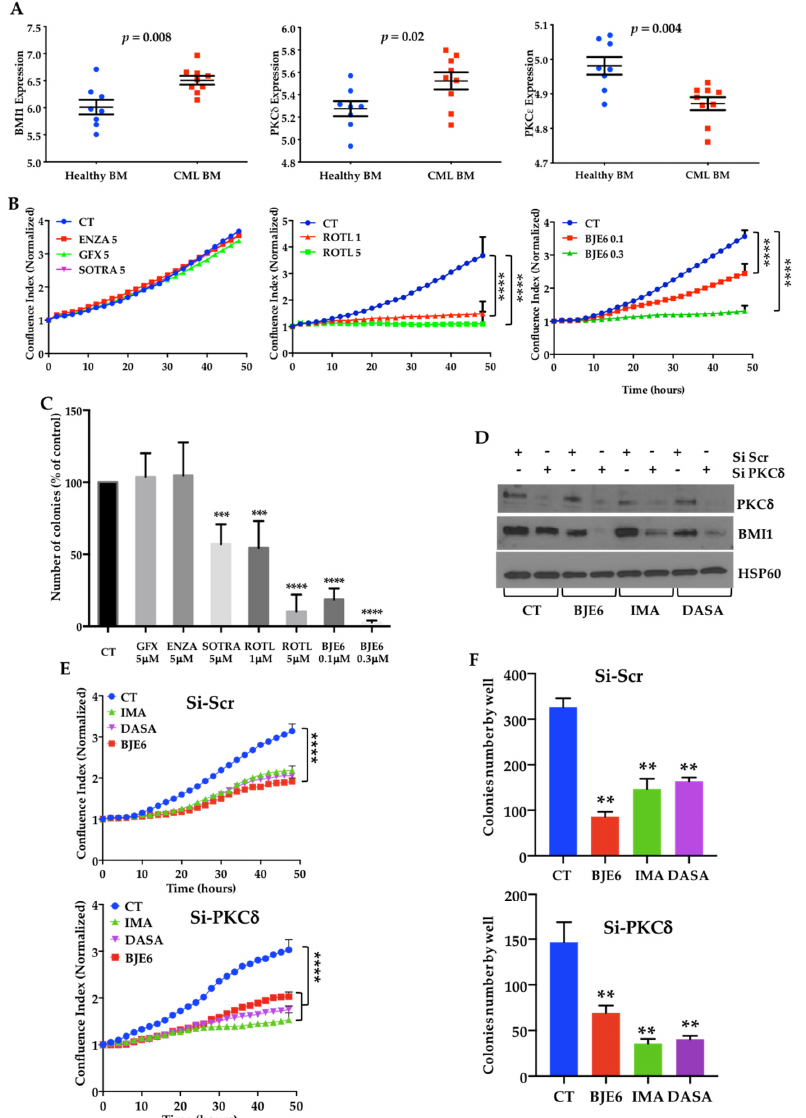
Figure 1. Targeting protein kinase C δ (PKC δ ) inhibited proliferation and clonogenicity of K562 cells. ( A ) BMI1, PKC δ , and PKC ε gene expression in bone marrow CD34 + cells from healthy donors and chronic myeloid leukemia (CML) patients (GSE5550). ( B ) Time-lapse proliferation analysis of K562 cells treated for 48 h with Dimethyl Sulfoxide (DMSO) (CT) and 5 µ M enzastaurin (ENZA), sotrastaurin (SOTRA), and GF109203X (GFX) (left panel); 1 and 5 µ M rottlerin (ROTL) (middle panel); and 0.1 and 0.3 µ M BJE6-106 (BJE6) (right panel). ( C ) Clonogenic analysis of K562 cells treated for seven days in the same conditions as ( B ). Results expressed as % of control (388 ± 17%). ** p < 0.01, *** p < 0.001, **** p < 0.0001, two-way ANOVA. ( D ) K562 cells transfected with 20 nM PKC δ -siRNA or scr-siRNA and treated for 24 h with DMSO (CT), 0.5 µ M BJE6, 1 µ M imatinib (IMA), or 2 nM dasatinib (DASA). Cell lysates were analyzed by immunoblotting for indicated proteins. ( E ) Time-lapse proliferation analysis of K562 cells transfected with 20 nM PKC δ -siRNA or scr-siRNA and treated for 48 h with DMSO (CT), 0.1 µ M BJE6, 1 µ M IMA, or 2 nM DASA. ( F ) Clonogenic analysis of K562 cells treated for 7 days in the same conditions as ( D ). Time-lapse analysis of cells performed with IncuCyte system. Graphs show quantification of cell numbers from phase-contrast confluence. Data represent mean ± SD ( n = 3). **** p < 0.0001, two-way ANOVA, Tukey’s multiple comparison. A.U., arbitrary